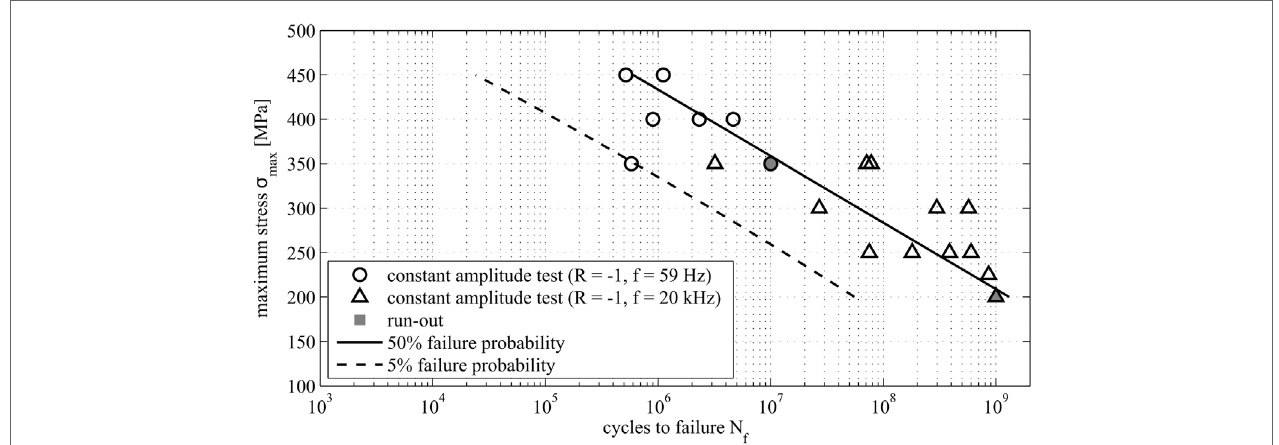
FigUre 6 | Very high cycle fatigue properties of stress-relieved Ti–6al–4V under tension–tension loading